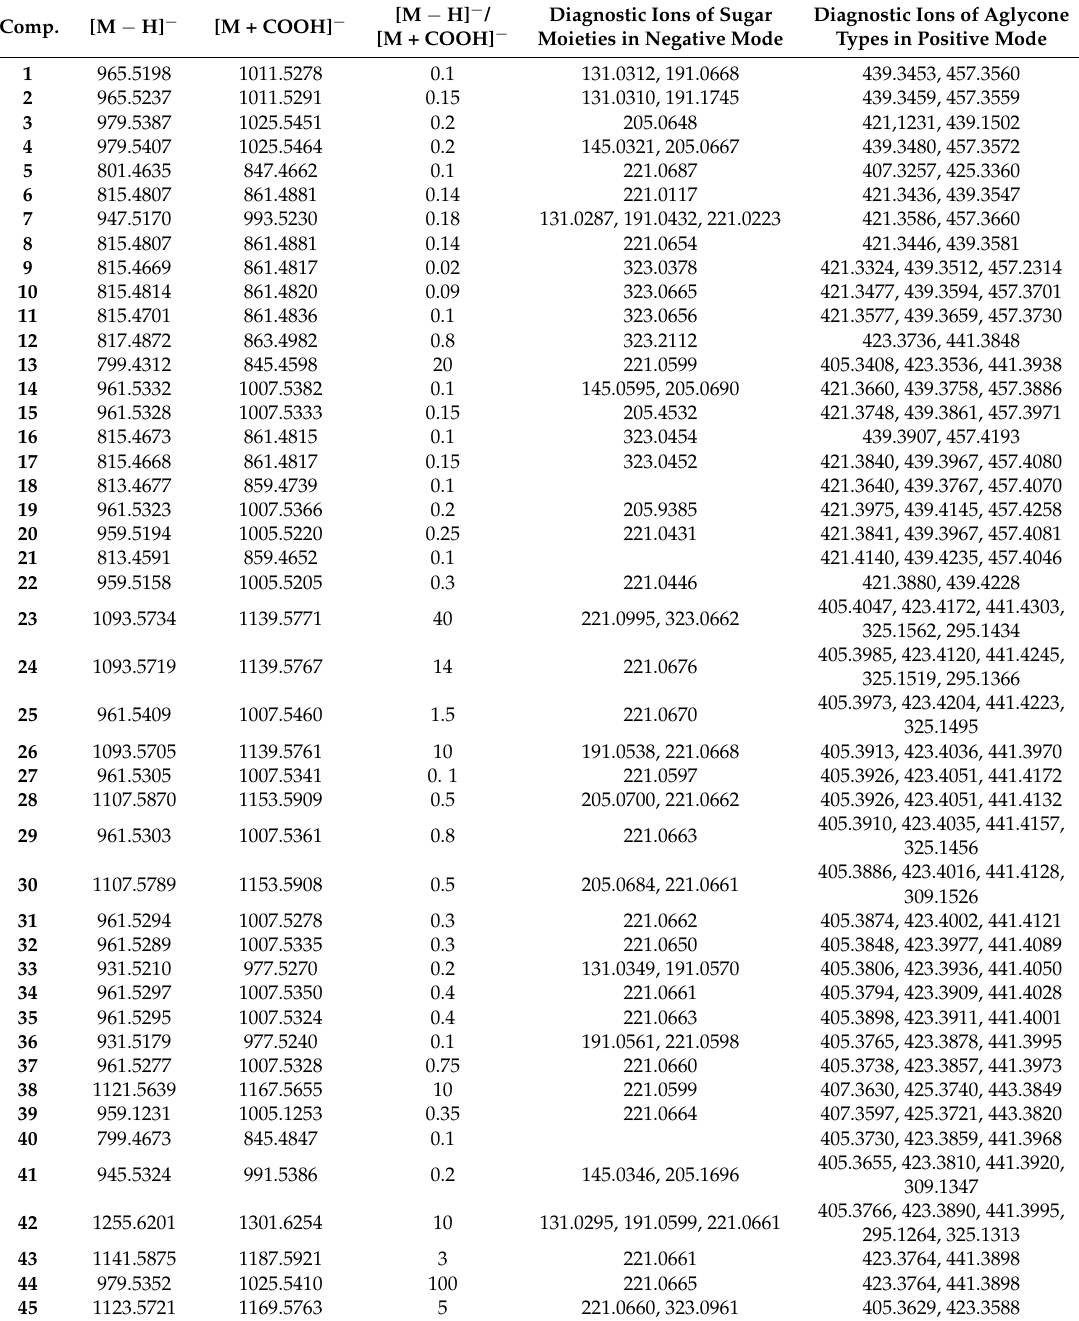
Table 1. The characteristic ions of saponins in